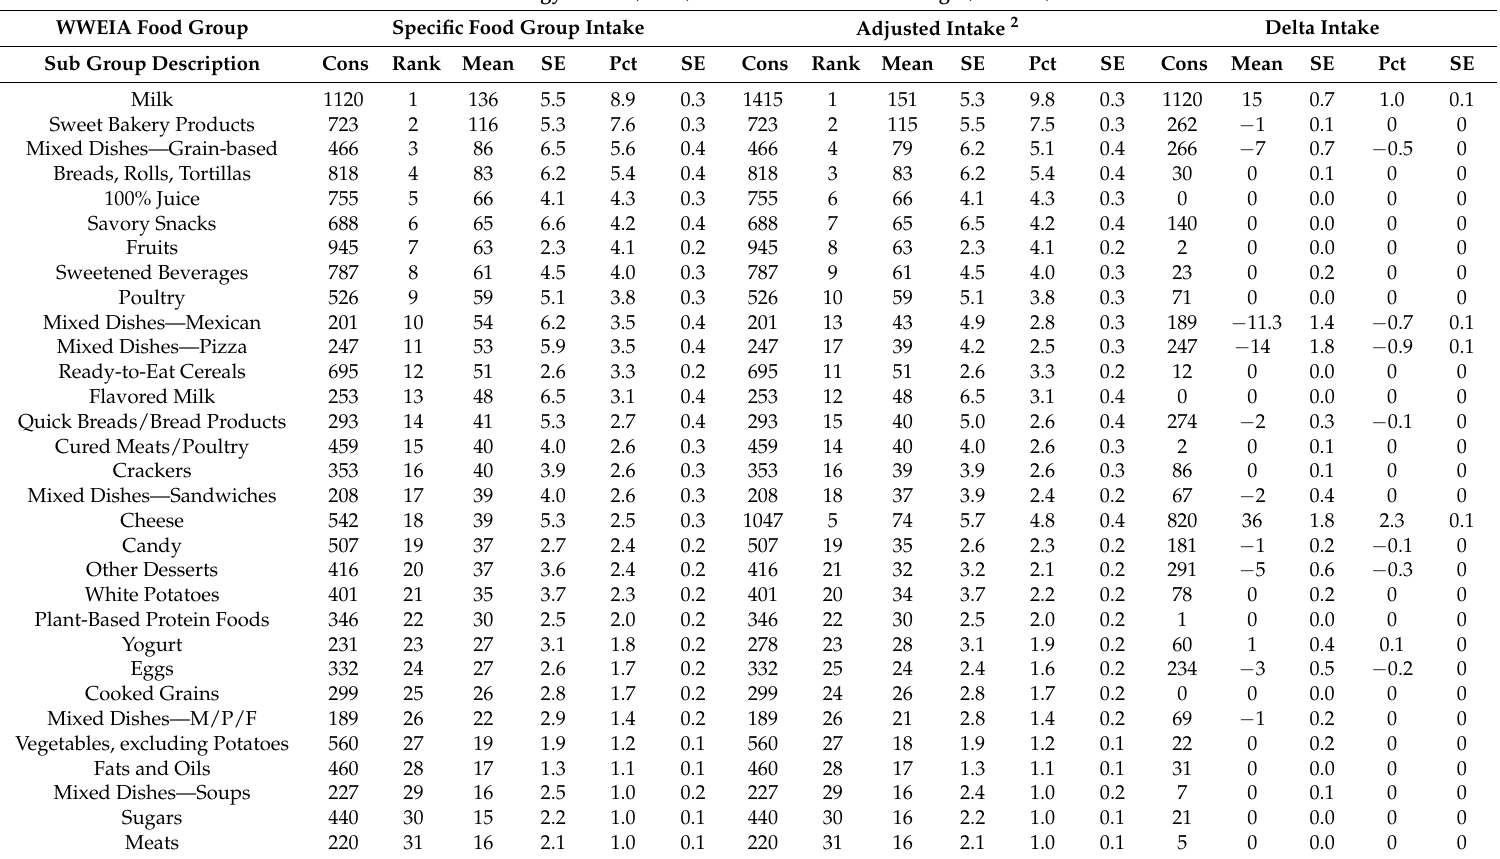
Table 1. Food/food group sources of mean energy (kcals) intake 1 among US children aged 2–18 years ( N = 5876): National Health and Nutrition Examination Survey